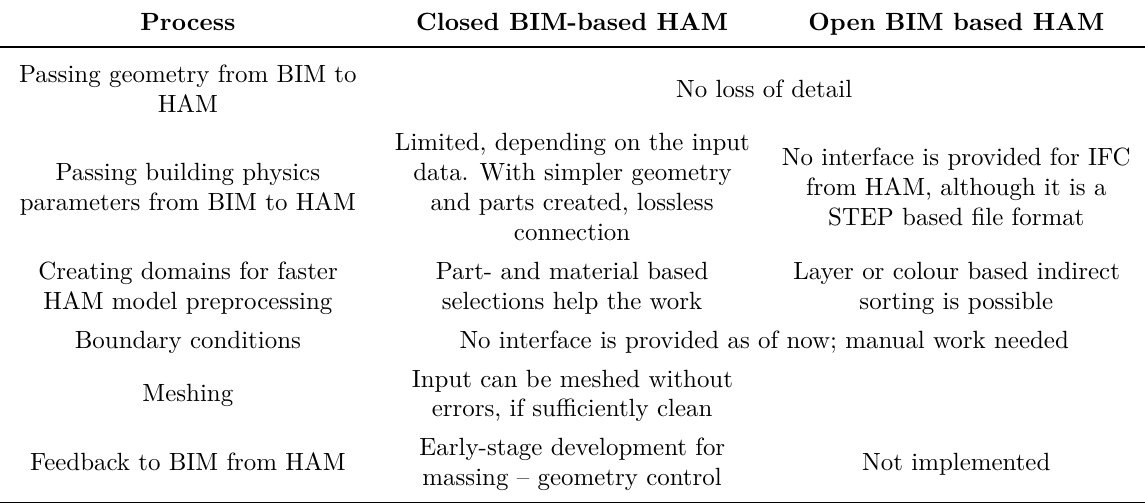
Table 1. Summary of the possibilities with BIM to HAM